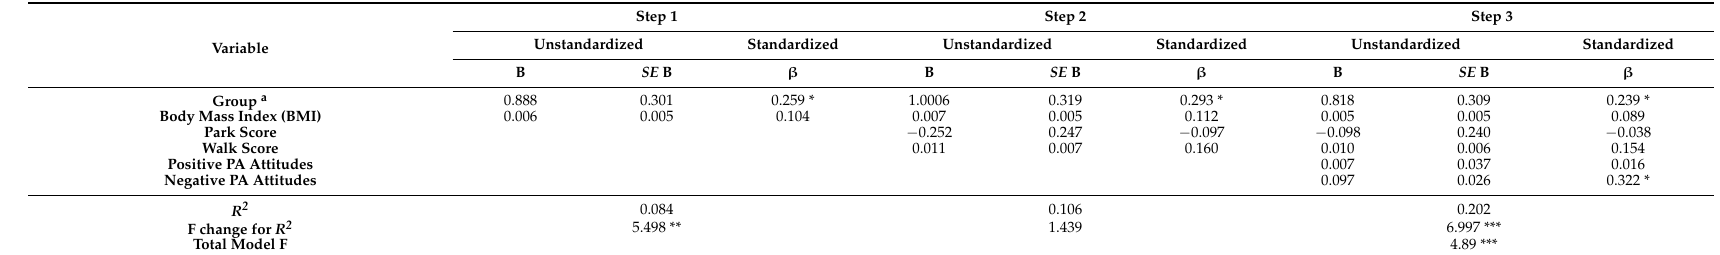
Table 2. Multiple regression model of adolescent usual pain intensity.